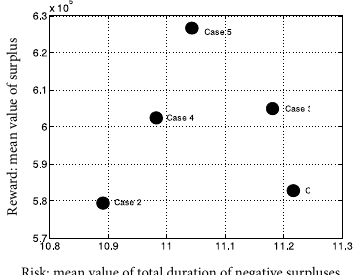
Fig. 10. The efficient frontier under Student’s t 2 copula without catastrophe event